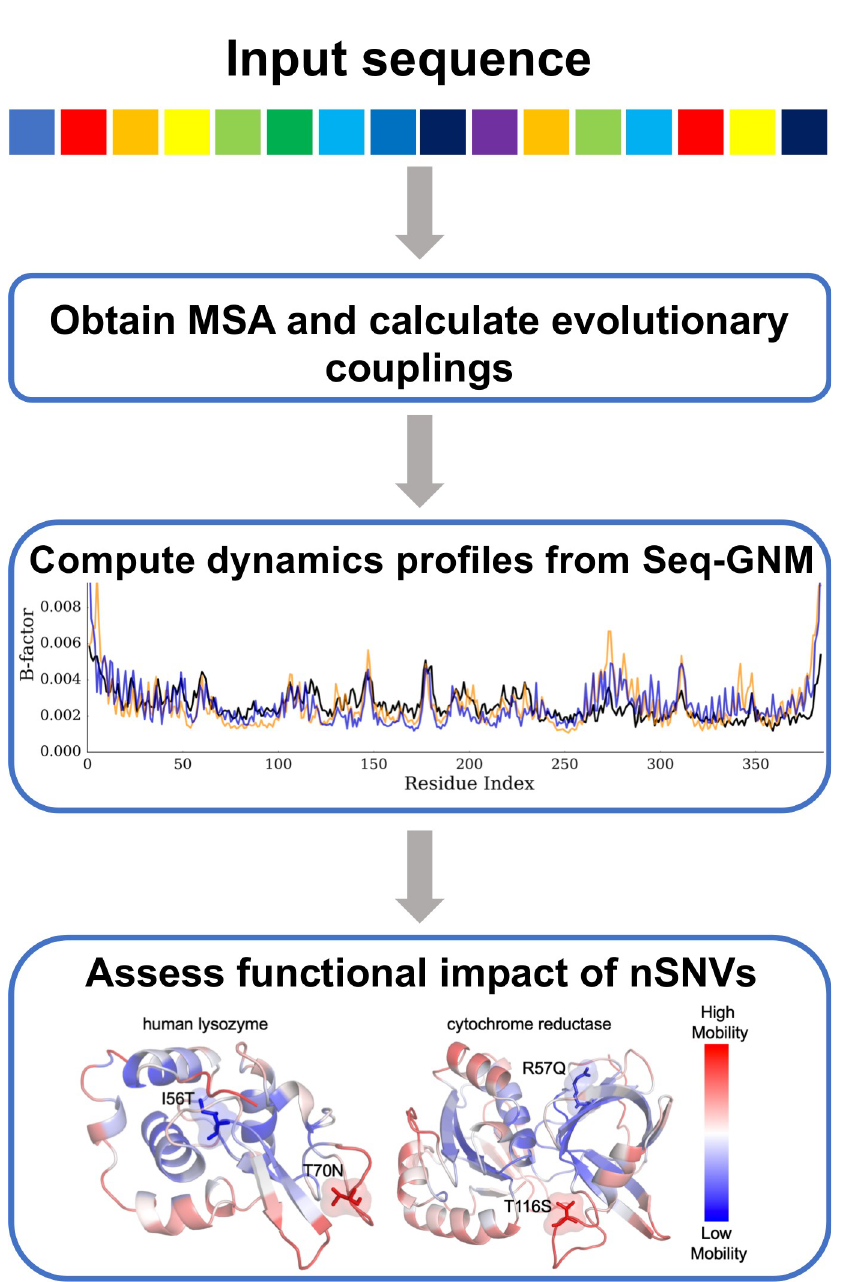
Fig 9. Flowchart of Seq-GNM method for nSNV predictions. A workflow of our method to use predicted evolutionary couplings to determine protein dynamics and assess the functional impact of nSNVs. The initial input is an amino acid sequence, which is used to obtain MSA. Using MSA evolutionary coupling pairs are predicted through RaptorX and EVcouplings. The high scored evolutionary coupling pairs are assigned as contacts in our Seq-GNM to compute the dynamics profile of each protein. The dynamic profiles obtained from Seq-GNM can give insight into the functional impact of nSNVs. This was done for a curated set of 139